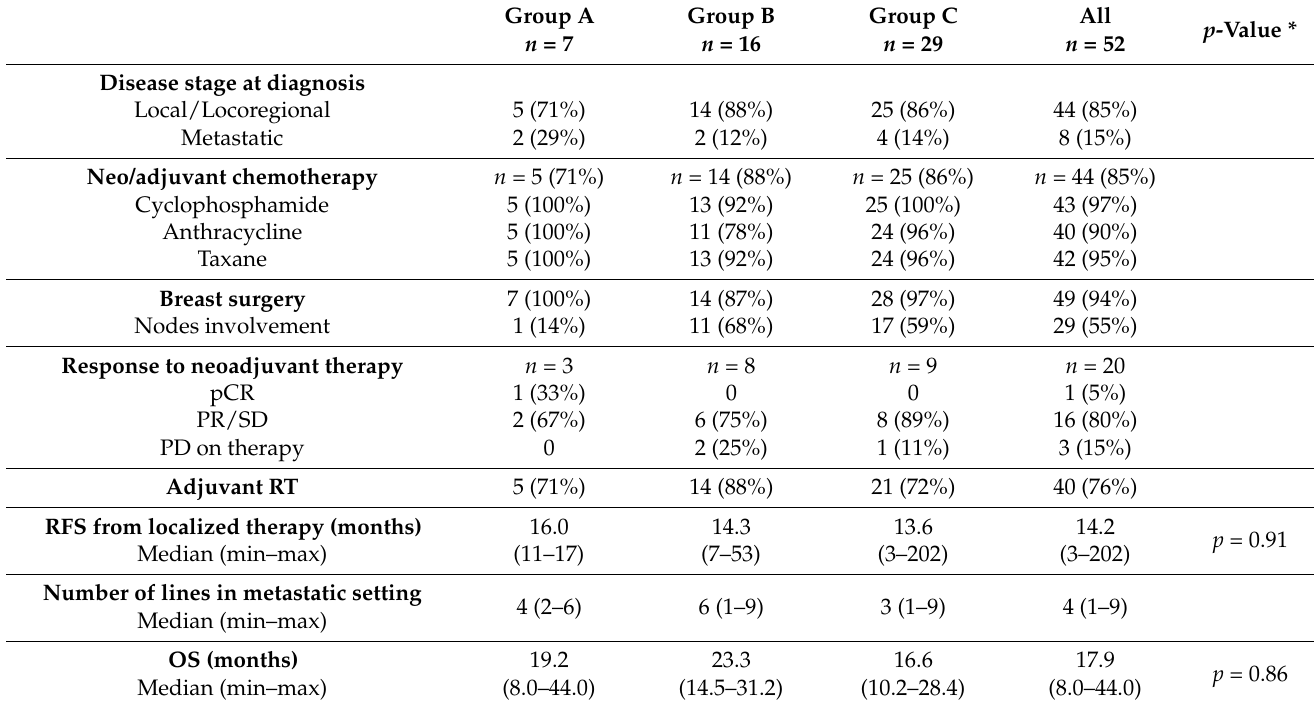
Table 2. Treatment’s Characteristics.